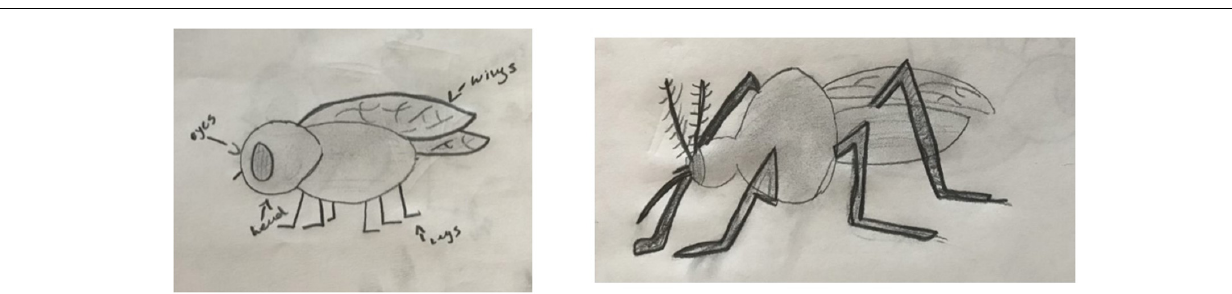
FIGURE 3 | Student illustration of a mosquito under a magnifying glass.